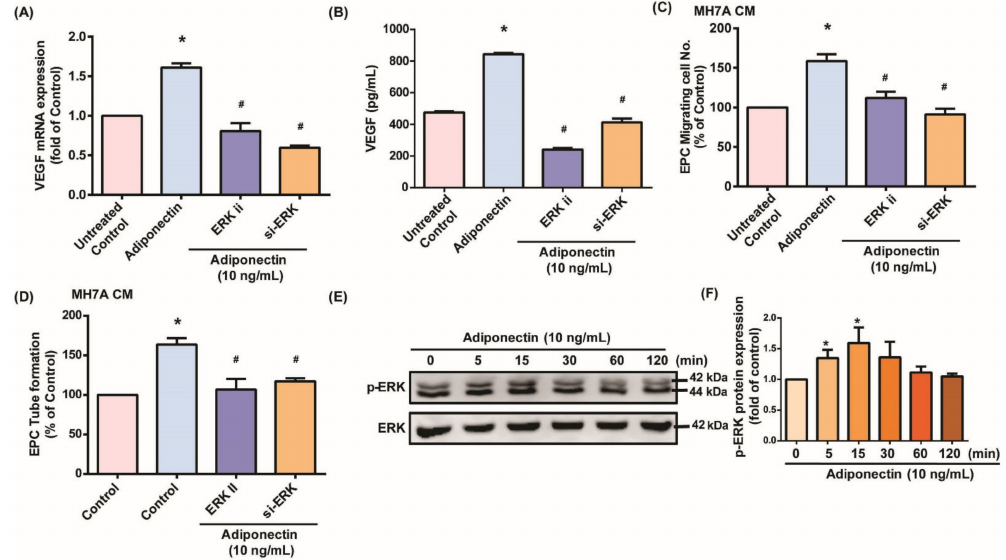
Figure 4. The ERK signaling pathway is essential in adiponectin-stimulated EPC migration and tube formation. ( A , B ) MH7A cells were left untreated, stimulated with adiponectin (10 ng/mL) alone for 24 h, or pretreated with ERK inhibitors (ERK II) or transfected with ERK siRNA for 30 min, prior to 24 h of adiponectin (10 ng/mL) stimulation. VEGF expression was examined by qPCR and ELISA assays ( n = 4 per group). ( C , D ) Collected CM from MH7A was applied to EPCs and angiogenesis was examined by the Transwell and tube formation assays ( n = 5 per group). ( E ) MH7A cells were treated with adiponectin for varying amounts of time and Western blot ( n = 3) determined ERK phosphorylation. ( F ) Densitometry analysis of ( E ). * p < 0.05 versus the control group; # p < 0.05 versus the adiponectin-treated